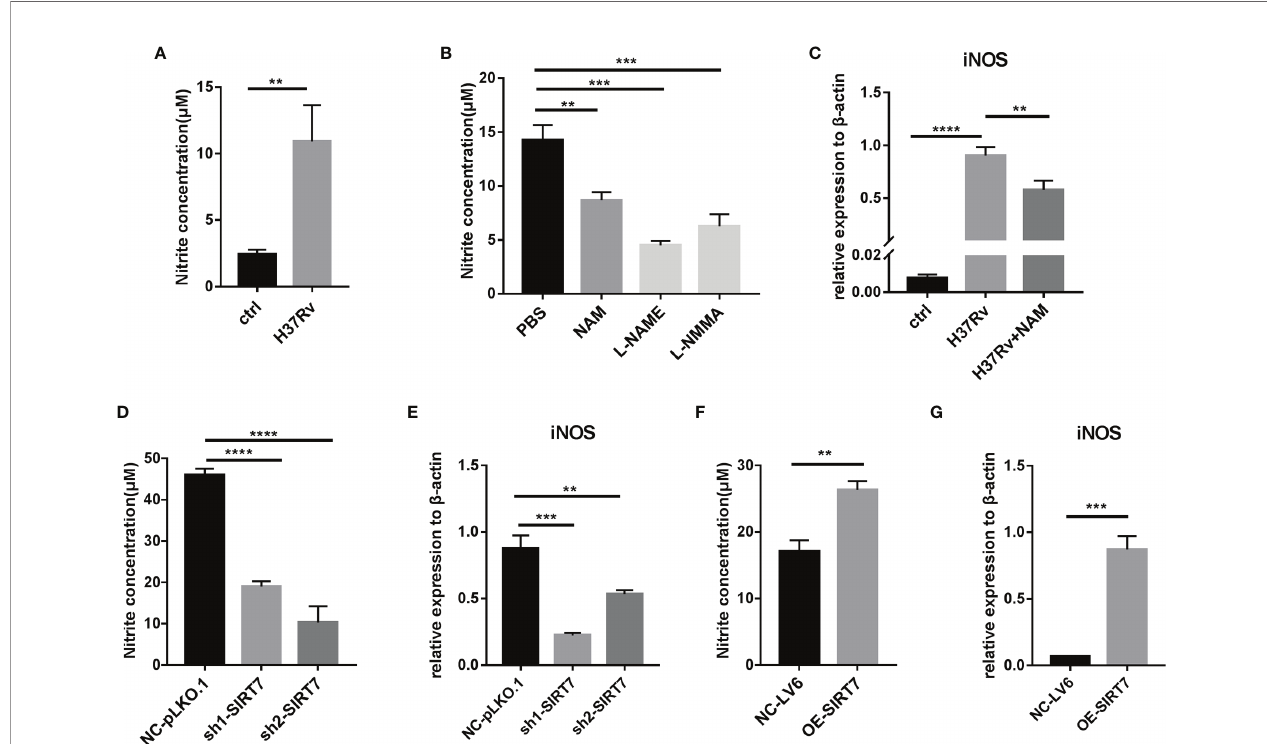
FIGURE 4 | SIRT7 inhibitor NAM or SIRT7-knockdown inhibits nitric oxide (NO) production in Raw264.7 cells. (A, B) NO production in Raw264.7 cells was measured by Griess reaction assay 24 h after infection with H37Rv (MOI 10:1) (A) or after pretreatment of cells with NAM (10 mM) or NOS inhibitors L-NMME (500 m M) and L-NMMA (500 m M) (B) . (C) Quantitative RT-PCR analysis of iNOS expression levels in infected Raw264.7 cells pretreated with or without NAM. mRNA was collected from the cells 24 h after infection with H37Rv. (D, E) NO concentration (D) and quantitative RT-PCR analysis of iNOS (E) expression levels in Raw264.7 cells stably expressing scrambled control (NC-pLKO.1) or two independent SIRT7 shRNAs (sh1-SIRT7 and sh2-SIRT7). (F, G) NO concentration (F) and quantitative RT-PCR analysis of iNOS (G) in Raw264.7 cells stably overexpressing SIRT7 (OE-SIRT7) and vector control (NC-LV6). Data are representative of three independent experiments with similar results and are presented as means ± SD. One way ANOVA was performed in (B – E) , Unpaired Student ’ s t-test was used in (A, F, G) . **p < 0.01; ***p < 0.001; ****p<